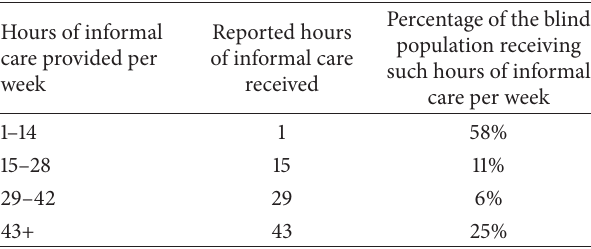
Table 2: The number of informal care hours provided by informal carers over the age of 15 years in the Republic of